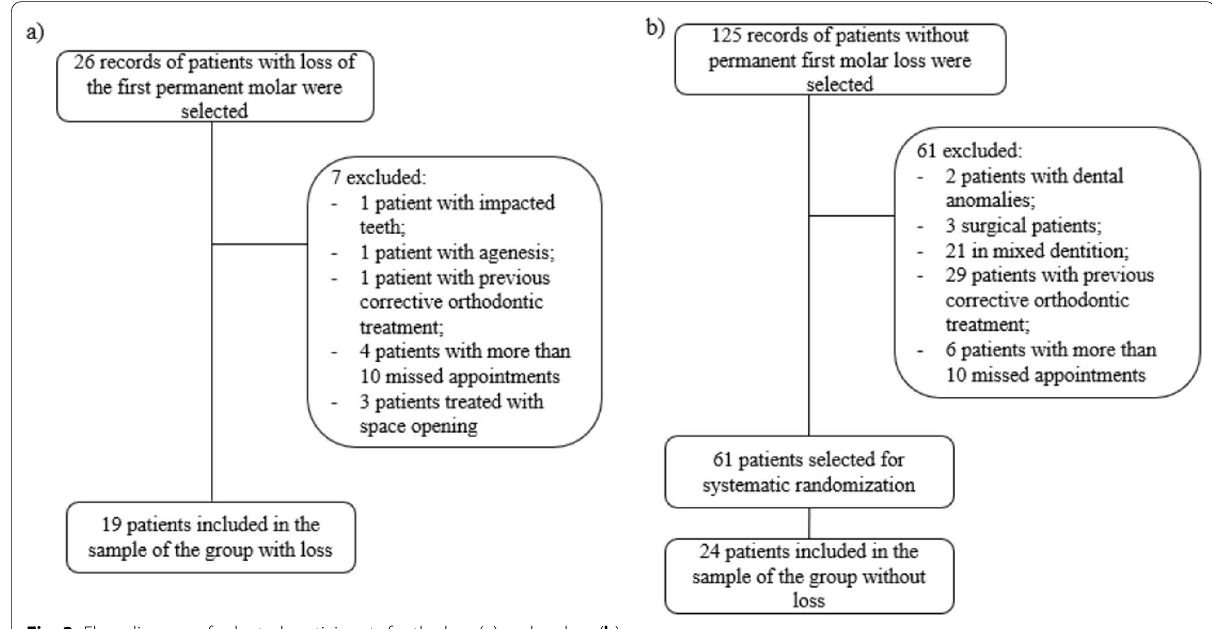
Fig. 3 Flow diagram of selected participants for the loss ( a ) and no loss ( b ) group